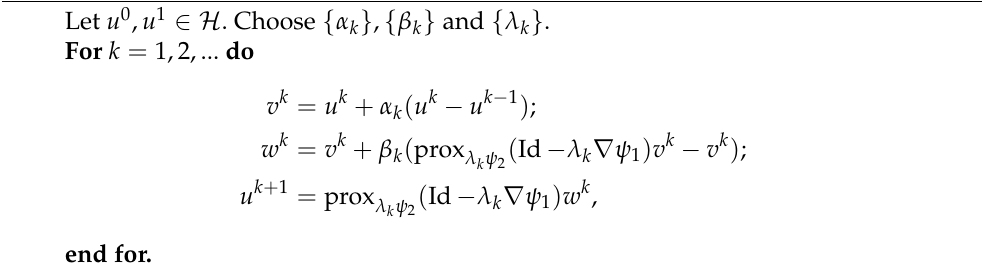
Algorithm 5 An inertial Picard–Mann forward–backward splitting (iPM-FBS)